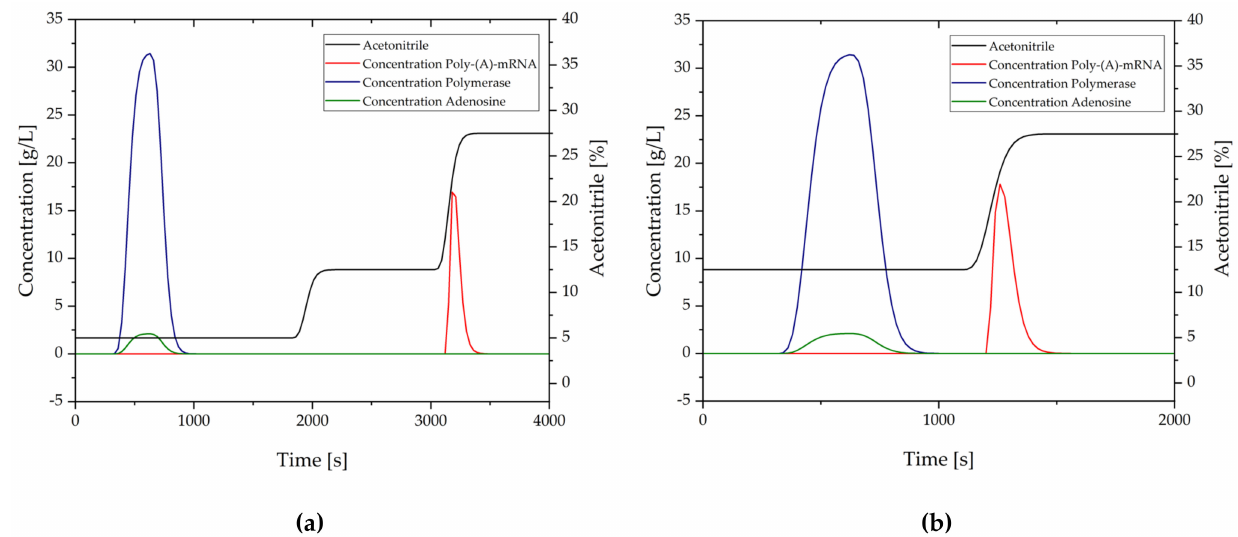
Figure 19. Comparison between the scale-up of the laboratory process ( a ) and the optimized laboratory process ( b